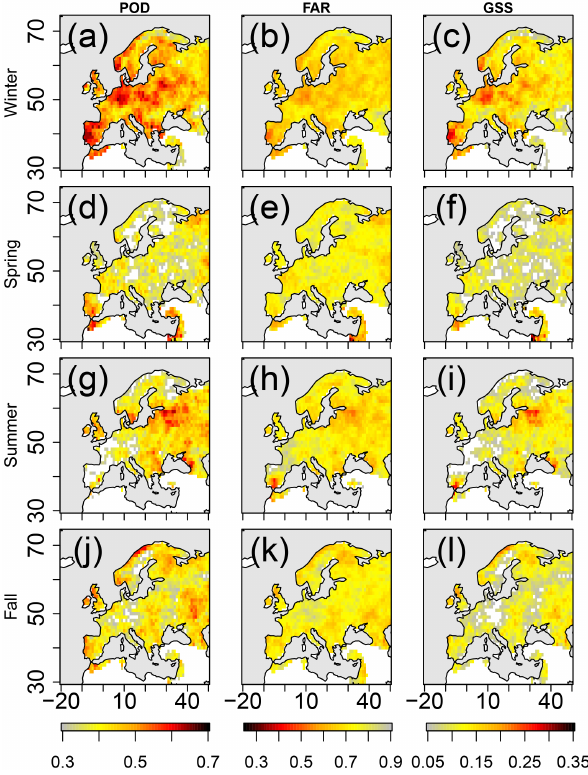
Figure 4. Anomalies of POD (a, d, g, j) , FAR (b, e, h, k) and GSS ∗ 2 (c, f, i, l) scores of drought prediction using the operational forecast with regard to the reference forecast. The scores are cal- culated for (from top to bottom) winter (a–c) , spring (d–f) , sum- mer (g–i) and autumn (j–l) . Improvement scores using the predic- tors are indicated in green (inverse scale for FAR). Only differences with confidence intervals larger than 90% are plotted. GSS is mul- tiplied by 2 to use the same scale as the other